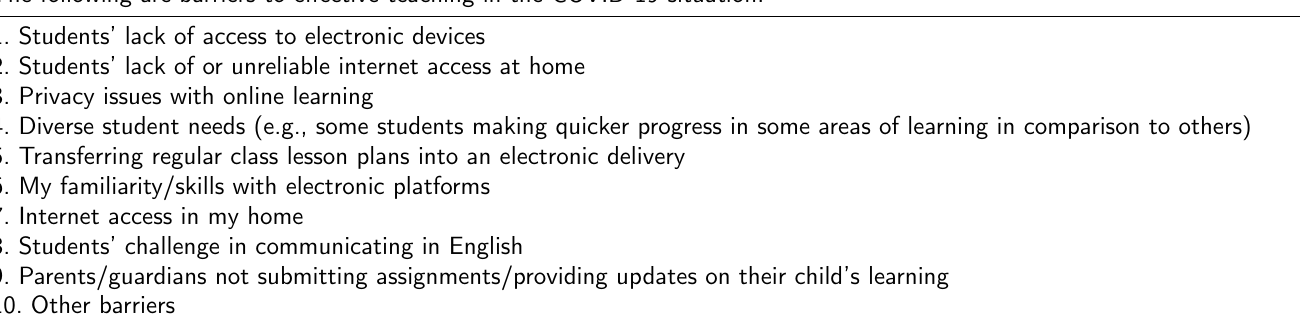
Table 2: Concerns about the return to school listed on the HiFLEC